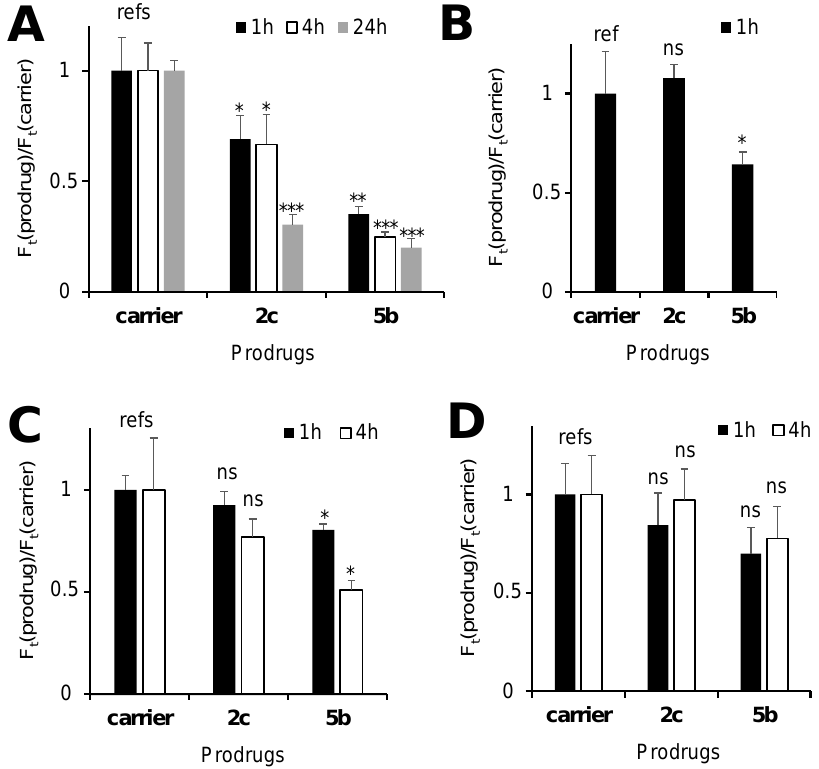
Figure 3. Effect of prodrugs 2c and 5b on relative organelle-specific staining (F t (prodrug)/F t (carrier)), with F: λ ex = 488 nm, λ em = 530 nm. ( A ) Mitochondria (Mit) staining with Rhodamine 123 (R123); t = 1, 4, 24 h. ( B ) Lysosomal staining with Acridine orange (AO); t = 1 h. ( C ) Endoplasmic reticulum (ER) staining with ER-Tracker-Green (ERG); t = 1, 4 h; ( D ) Golgi (G) staining with Golgi-Staining-Green (GO); t = 1, 4 h. *: p < 0.05; **: p < 0.01; ***: p < 0.001; ns: non-significant (Student’s t -test). Figure S57: Representative flow cytometric histograms used for setting up Figure 3A – D (main text) and Figure 5A.